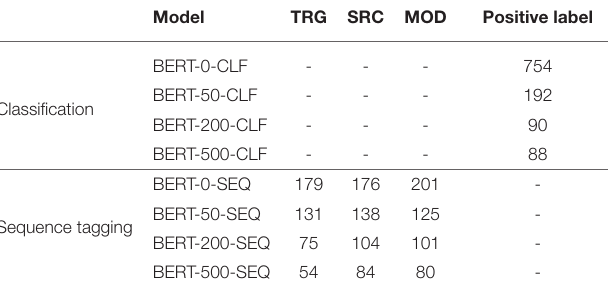
TABLE 5 | Number of positive labels and tags that were predicted from the different models for both tasks. Model TRG SRC MOD Positive